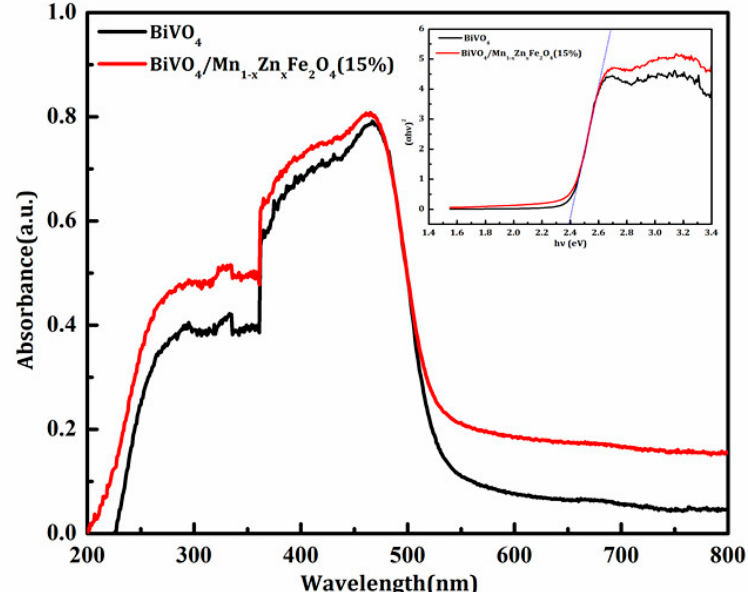
Figure 7. UV-Vis diffuse reflectance spectra of pure BiVO 4 and BiVO 4 /Mn 1 − x Zn x Fe 2 O 4 (15 wt %) samples. Inset: the plot of (Ah v ) 2 vs. hv to estimate the Eg value.